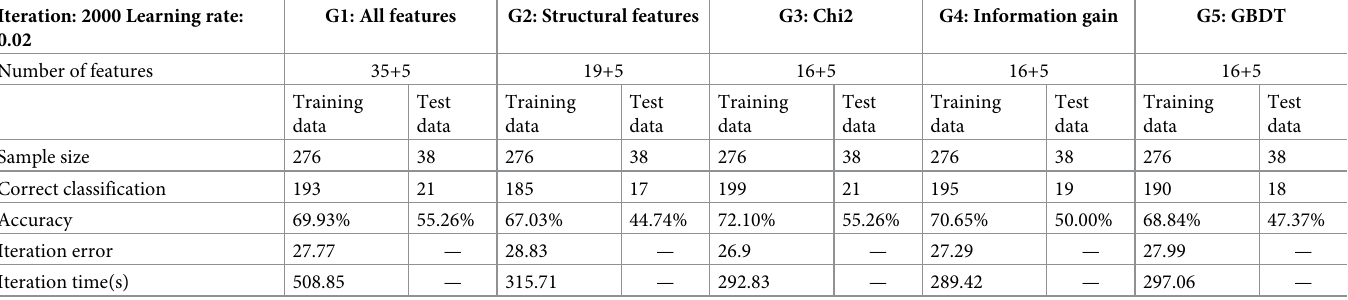
Table 4. Results of training 2000